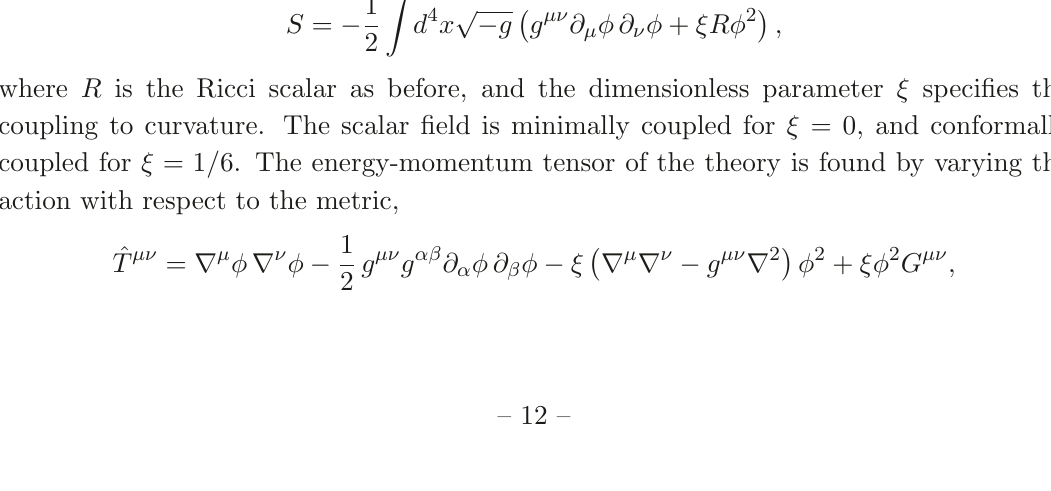
Figure 1 . The one-loop diagram contributing to the fermions. The two vertices denote the two energy-momentum tensor insertions, the lines are the fundamental field propagators, and p denotes the loop momentum which needs to be integrated out. The hat in ˆ T µν signifies that it is an operator made out of the fundamental fields. Similar diagrams arise for free scalar as well as for free gauge